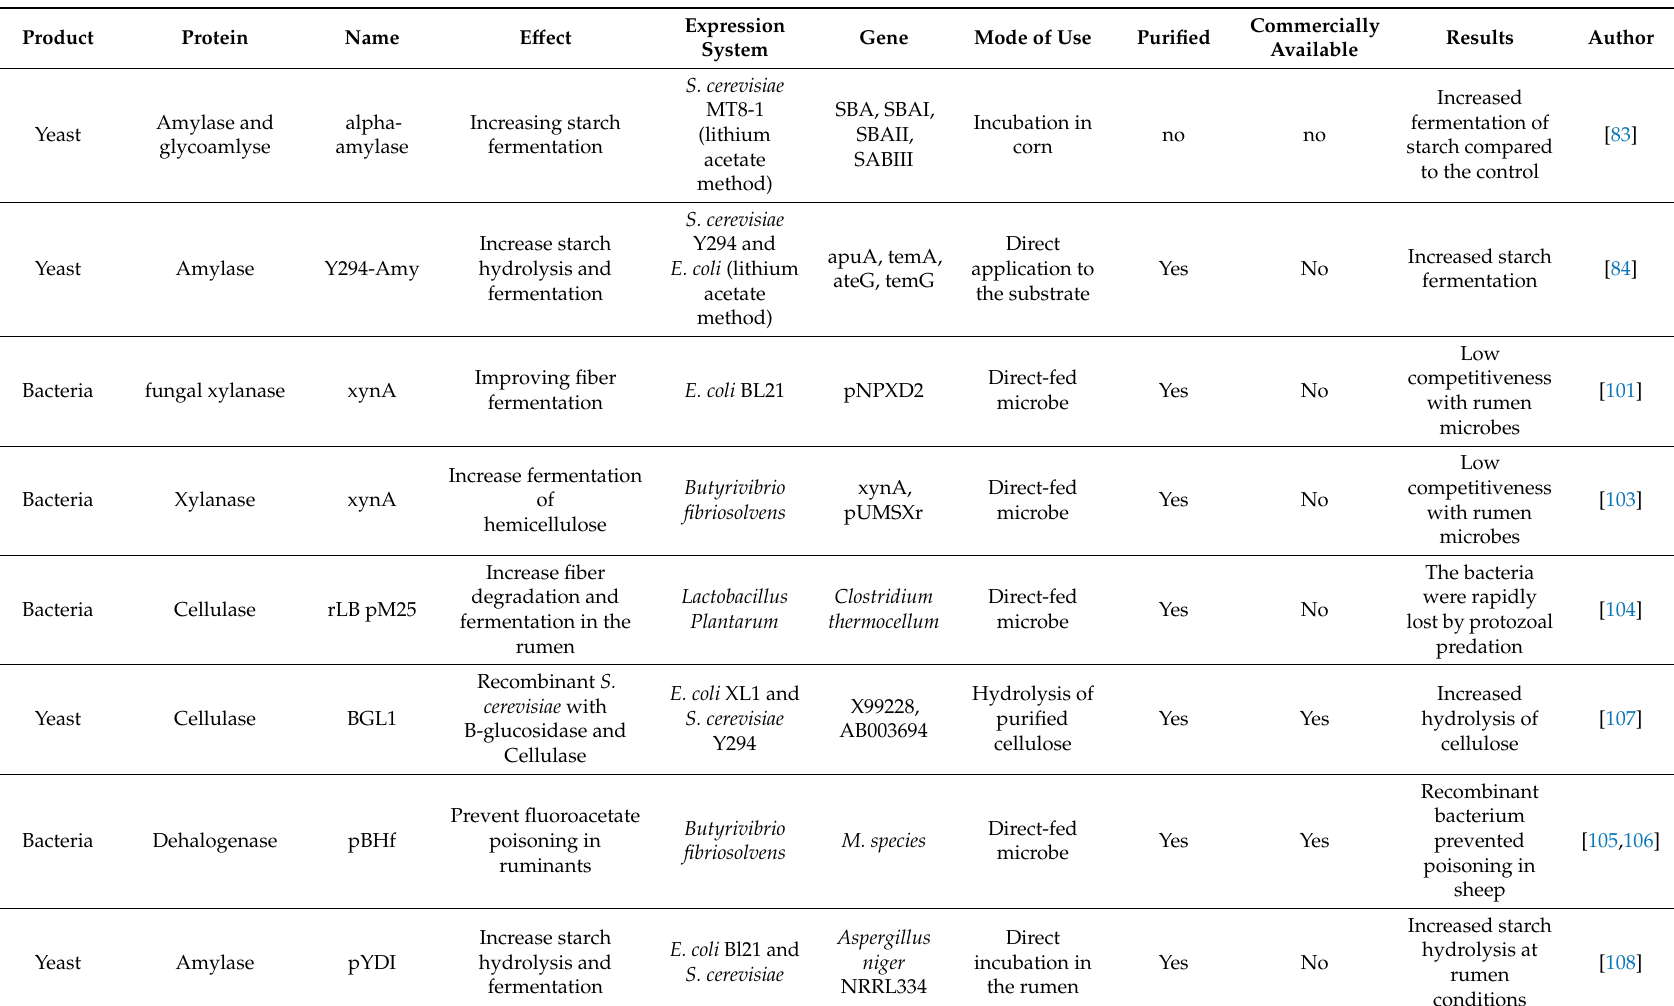
Table 4. Summary of e ff ects of recombinant direct-fed microbes (DFM) on the in vitro and in vivo rumen fermentation and health of